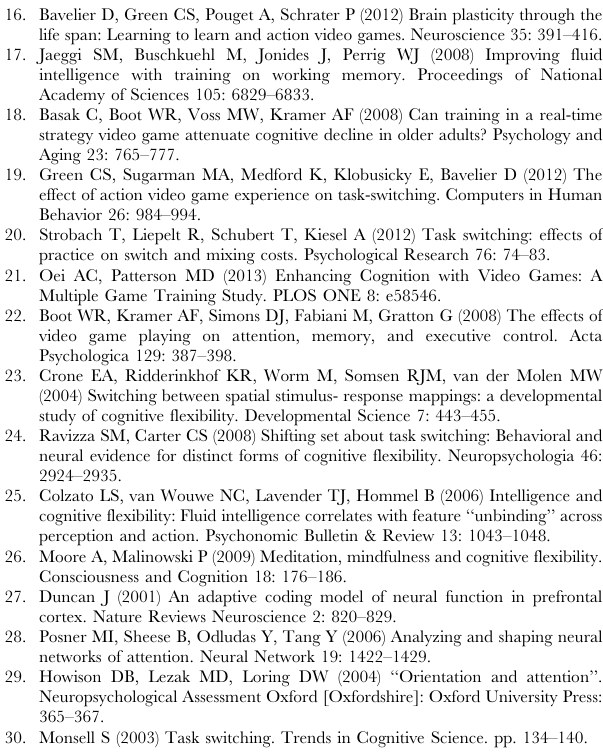
Table S4 ANT, post-test minus pre-test, with standard error in parentheses. Table S5 Multi-location memory task, post-test minus pre-test, with standard error in parentheses. Table S6 Ospan test, post-test minus pre-test, with standard error in parentheses. Table S7 Visual search task, post-test minus pre-test, with standard error in parentheses. Table S8 WAIS-IV digit span test, post-test minus pre- test, with standard error in parentheses. Table S9 Information filtering task, post-test minus pre-test, with standard error in parentheses. Table S10 Balloon Analog Risk Taking, post-test minus pre-test, with standard error in